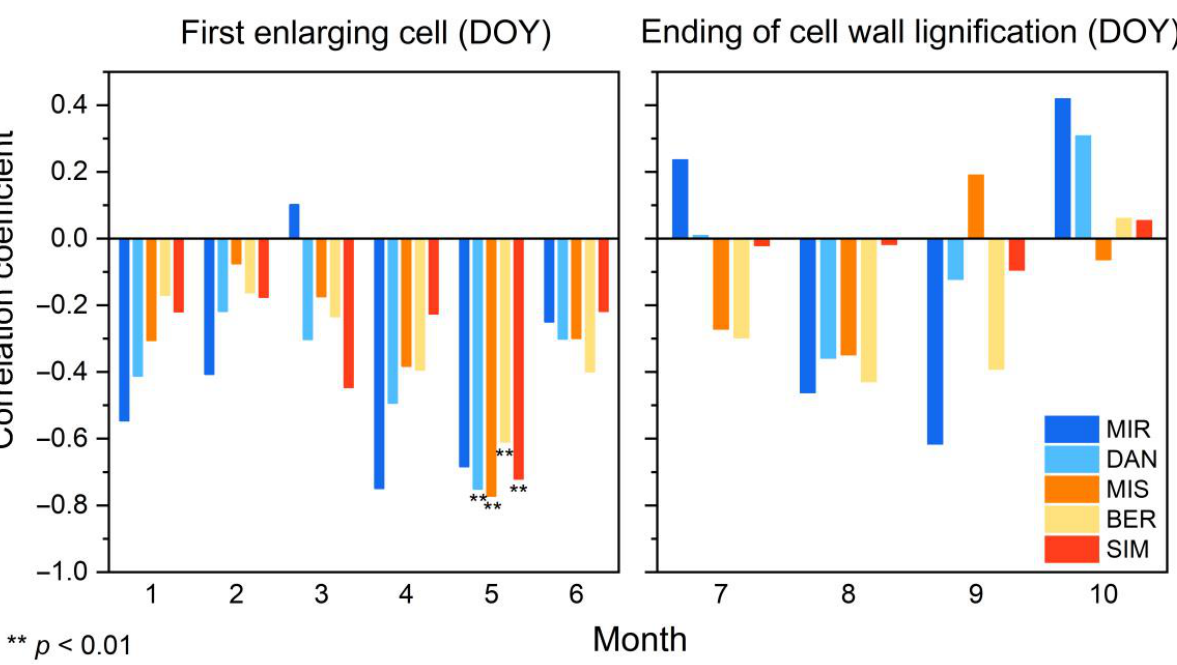
Figure 6. Correlations between the onset and ending of xylogenesis and monthly temperature at five permanent sites in the boreal forest of Quebec, Canada.